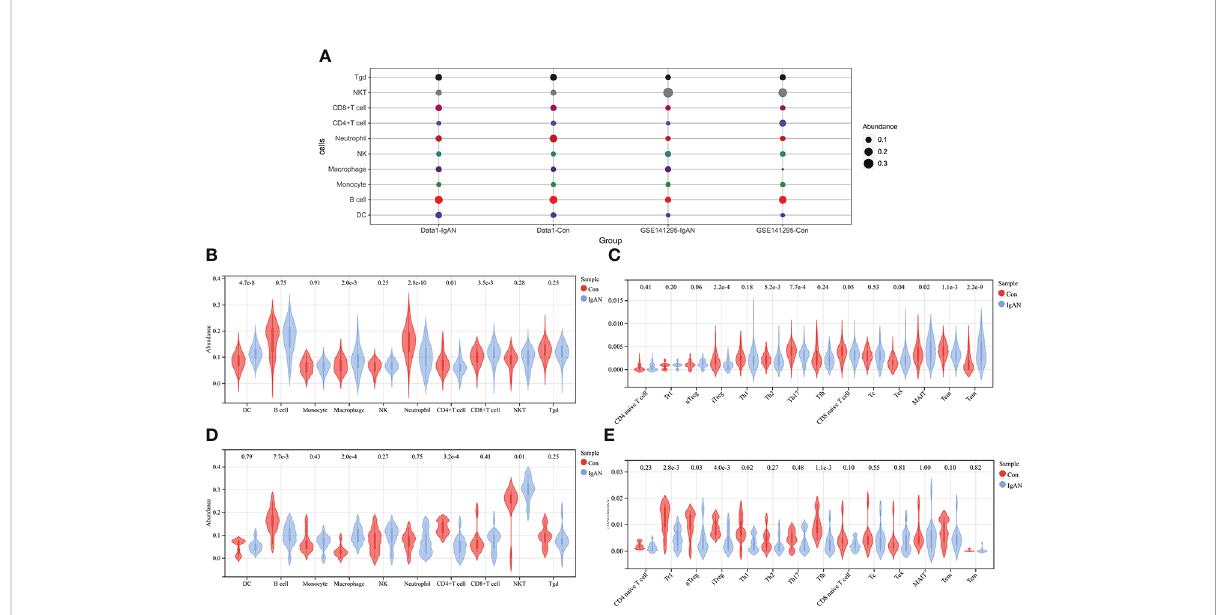
FIGURE 2 ssGSEAof data1andGSE141295. (A) Differencesin10 layer1immunecell in fi ltrationbetweenIgANandcontrols.Eachrowrepresentsatype of immune cell;eachcolumn, adifferentgroup. (B) Differences inabundance of 10typesof layer1immunecellsbetweenIgANandcontrolsof data1. (C) Differencesin abundance of 14typesof layer2 immunecellsbetweenIgANandcontrolsof data1. (D) Differencesinabundanceof10 types of layer1immunecells betweenIgANandcontrolsof GSE141295. (E) Differencesinabundanceof 14 typesoflayer2immunecellsbetween